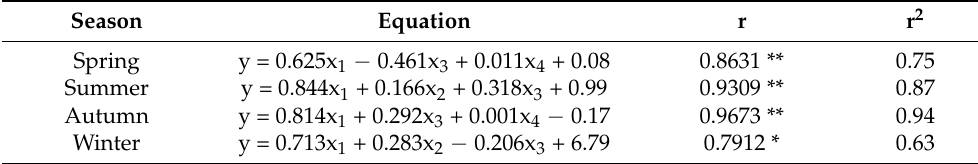
Table 3. The prediction model of temperature based on stepwise regression